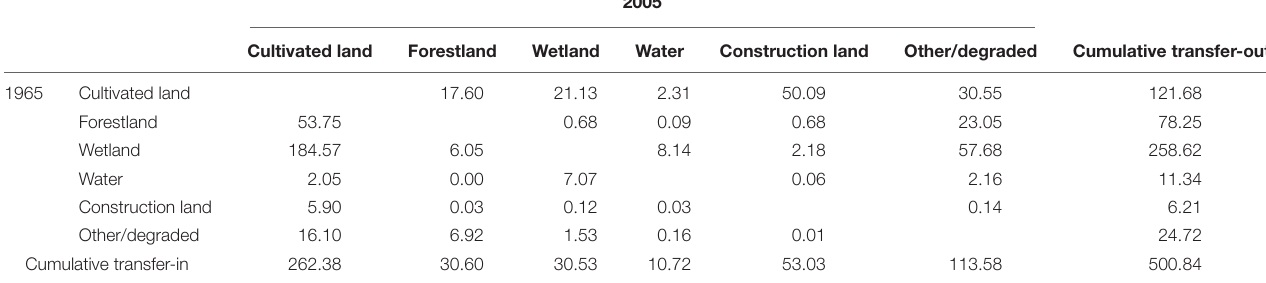
TABLE 2 | Land use transfer matrix from 1965 to 2005 (km 2 ).